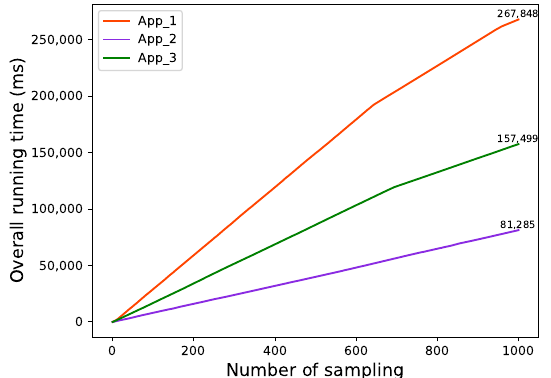
Figure 9. Overall running time of each App without